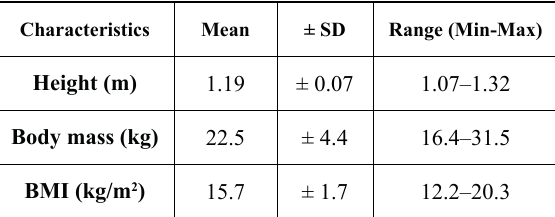
Table 1 . Anthropometric data of children ( n = 30), mean ± SD